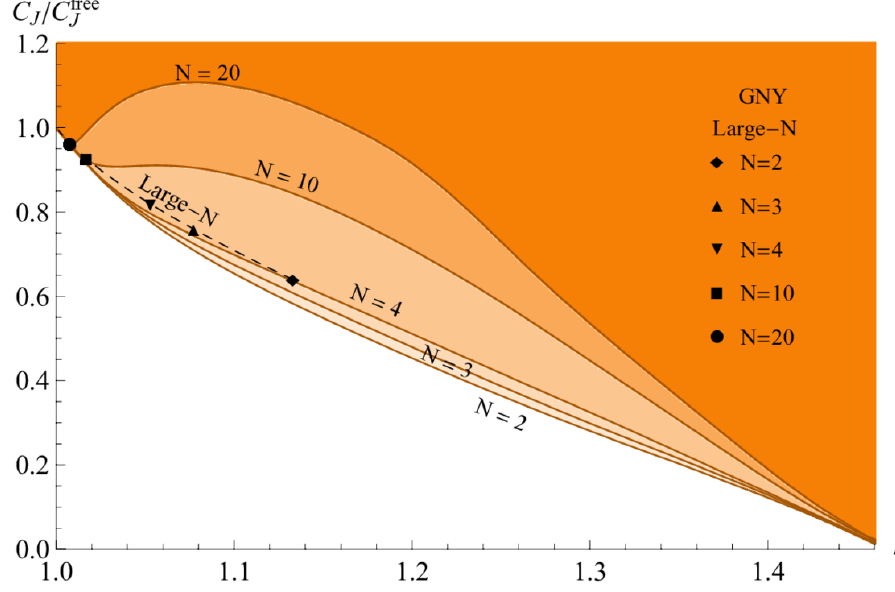
Figure 6 . Lower bounds on the O ( N ) conserved current central charges C J as a function of the scaling dimension (cid:1) . We normalize the central charges C J such that as (cid:1) ! 1, we set the value of C J = 1. For N = 10 ; 20 the bound has a local minimum that lies close to the large- N values of ((cid:1) ; C J ) in GNY models obtained up to O (1 =N 2 ) corrections (black markers) [45]. This is reminiscent of the central charge bound in the scalar bootstrap which had a local minimum corresponding to 3D Ising model. The bounds for smaller values of N have no similar